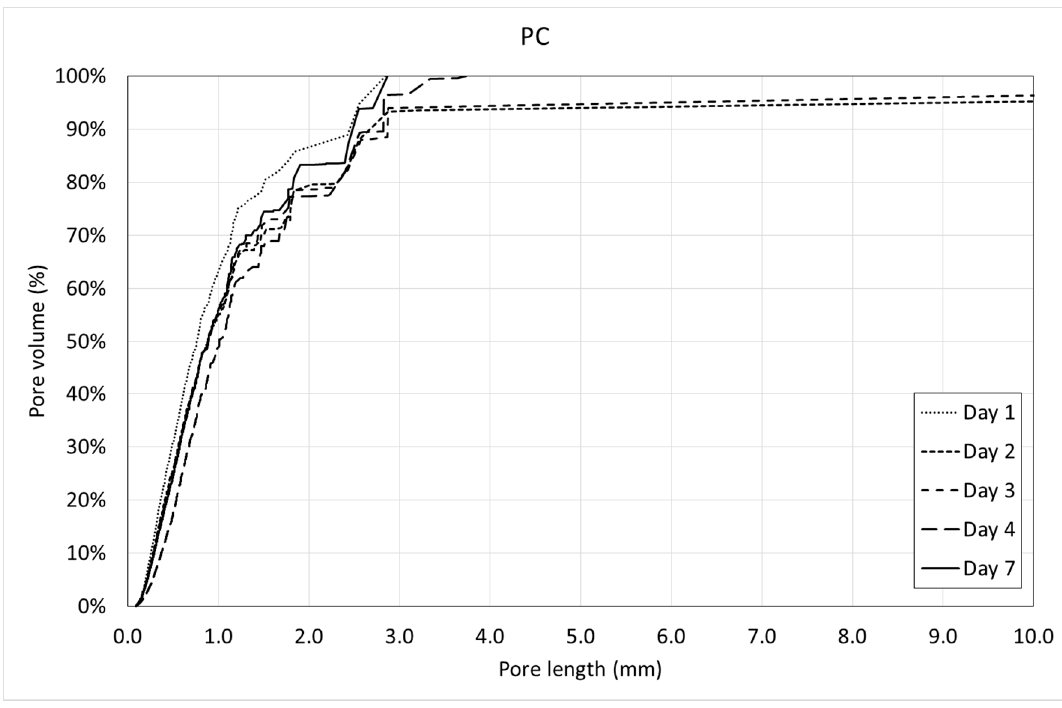
Figure 16. Porosimetric curves of PC.